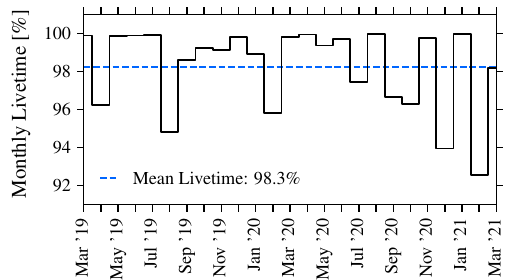
Fig. 2 MonthlylivetimeofSTRAWoverthelast2years,duringwhich a mean livetime of 98.3% was achieved. The primary downtime periods are due to planned maintenance shutdowns of the undersea network